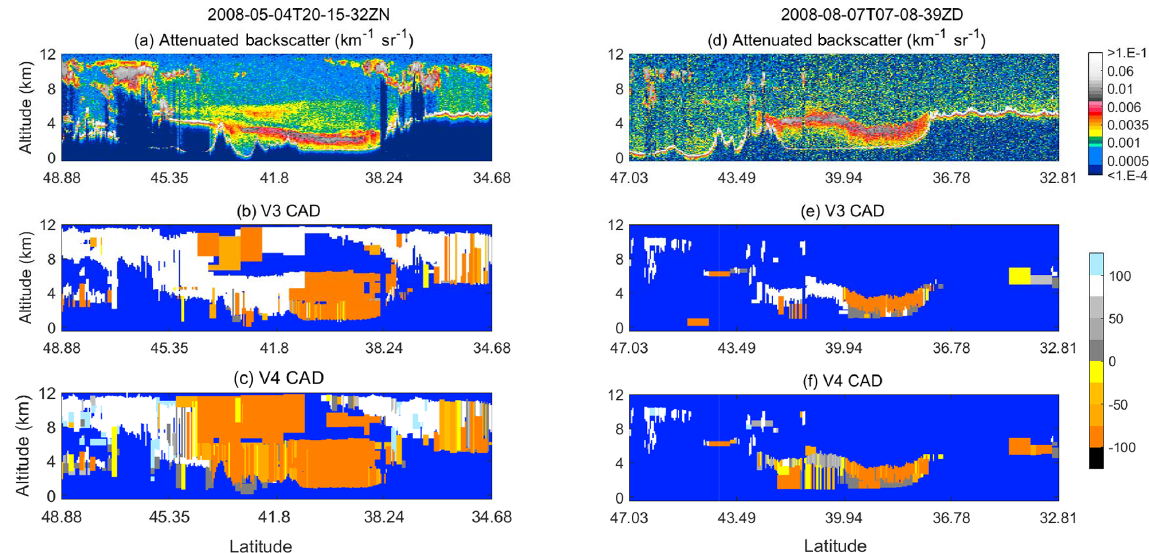
Figure 11. V4 532nm attenuated backscatter coefficients (a, d) , V3 CAD scores (b, e) , and V4 CAD scores (c, f) for the granule 2008-05- 04T20-15-32ZN located between 31 and 49 ◦ N (a–c) and for the granule 2008-08-07T07-08-39ZD located between 29 and 47 ◦ N (d–f)